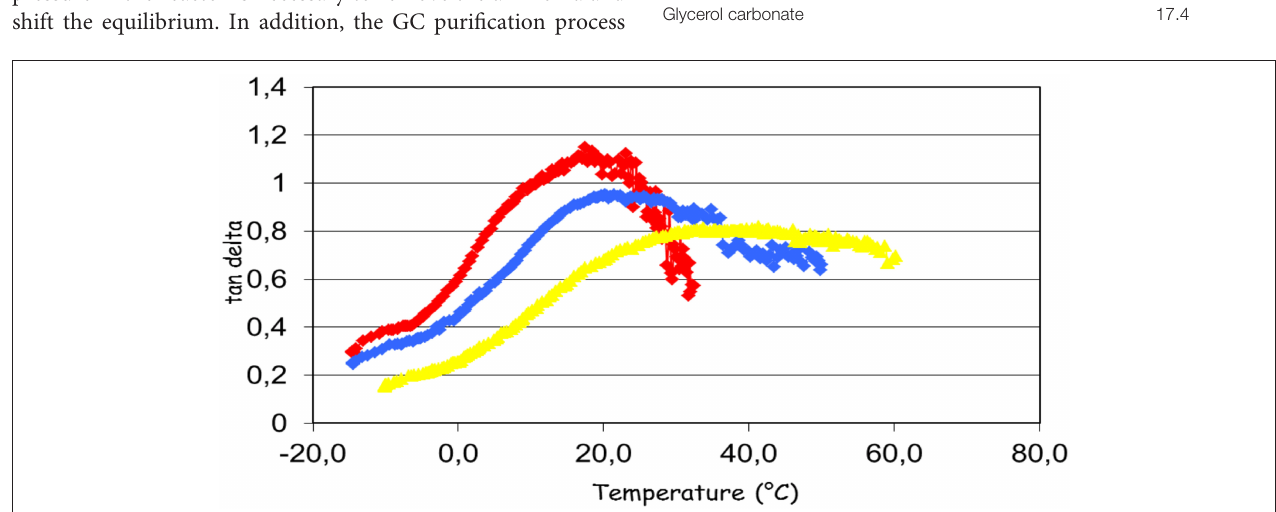
Frontiers in Chemistry |